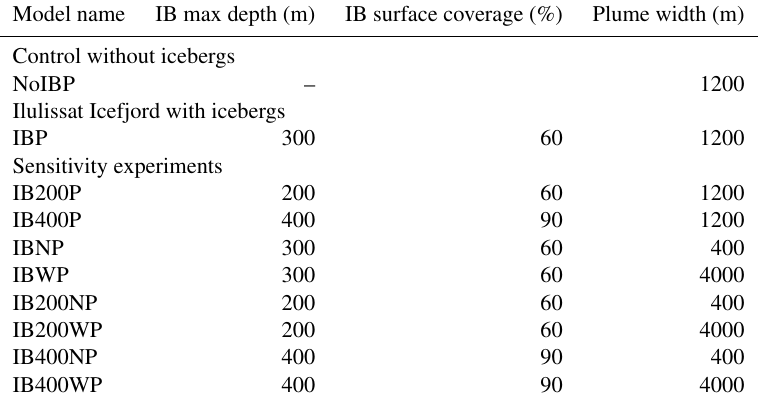
Table 1. Experiment naming and key parameters. IB denotes iceberg. Model